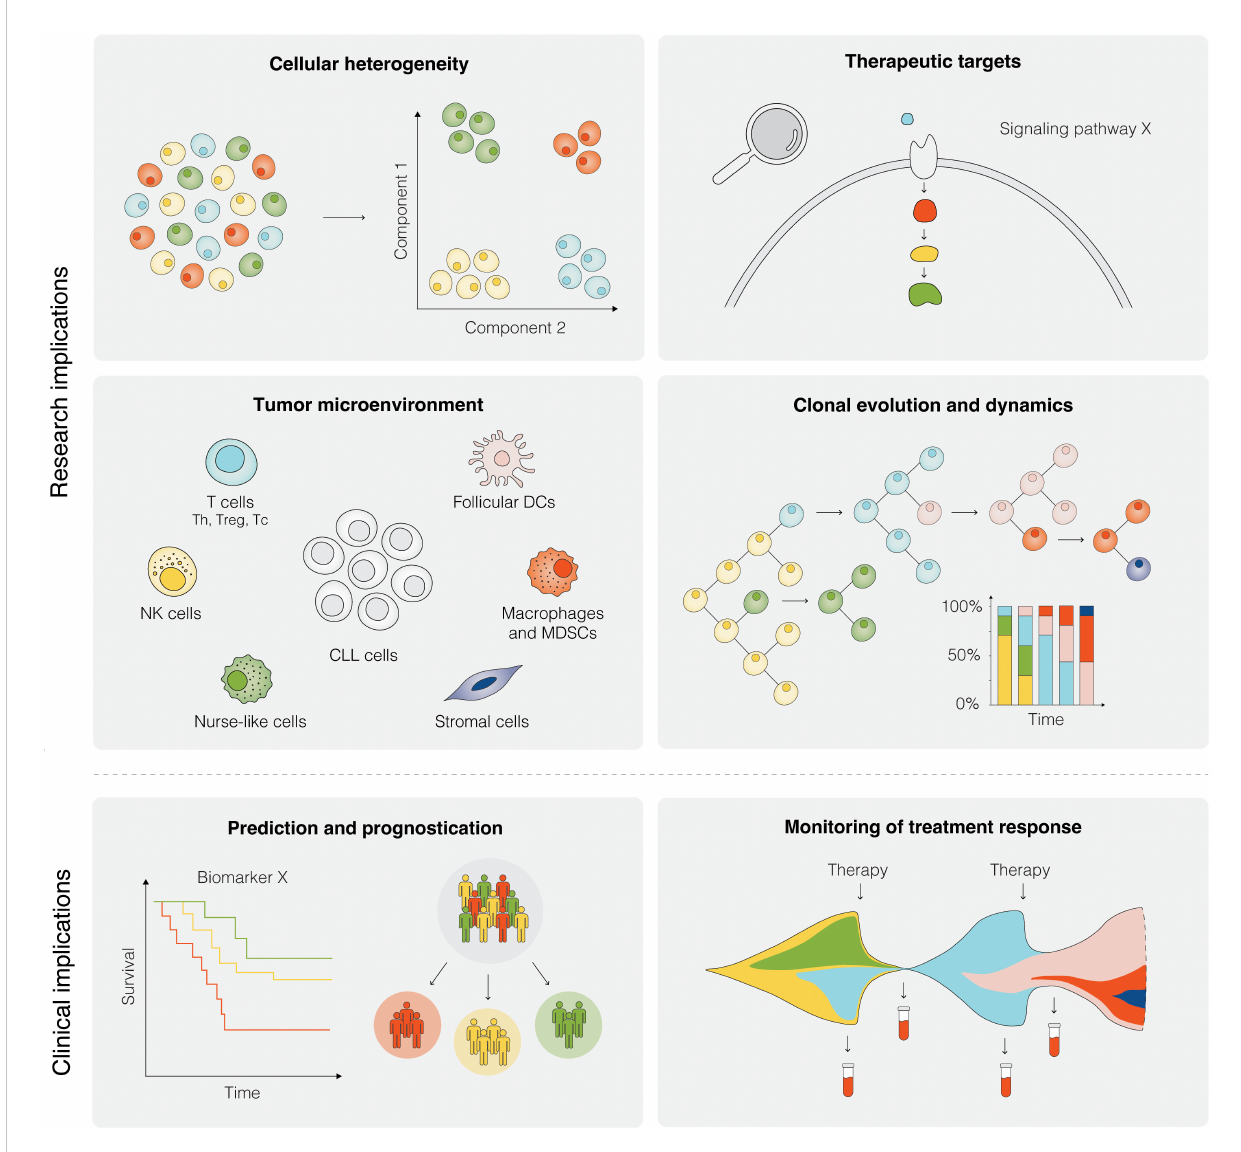
FIGURE 5 Research and clinical implications of SCS in CLL. Research implications of SCS include studies of cellular heterogeneity, identi fi cation of potential therapeutic targets, investigation of the TME, and analyses of clonal evolution and dynamics, among others. Clinical implications of SCS are still remote, but could include the prediction of therapeutic intervention, prognostication of clinical outcome, and therapy